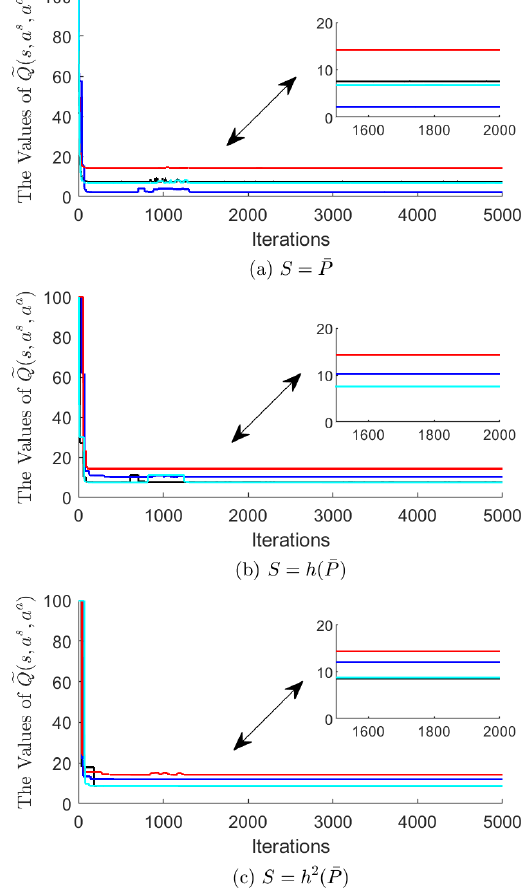
Figure 6. Learning process of Q ( s , a s , a a ) for unreliable